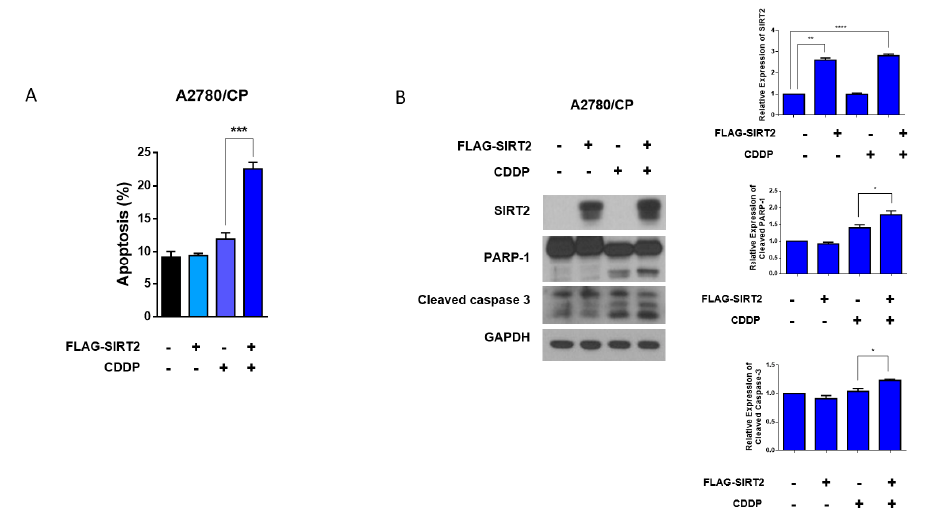
Figure 6. A2780 / CP cells were transfected with FLAG-SIRT2 overexpression plasmid or negative control plasmid (5 µ g) for 24 h, followed by cisplatin treatment (10 µ M) for 48 h. Cell apoptosis was evaluated by flow cytometry ( A ) and Western blotting ( B ). Results are shown as mean ± SEM (* p ≤ 0.05, ** p ≤ 0.01, *** p ≤ 0.001, **** p ≤ 0. 0001).